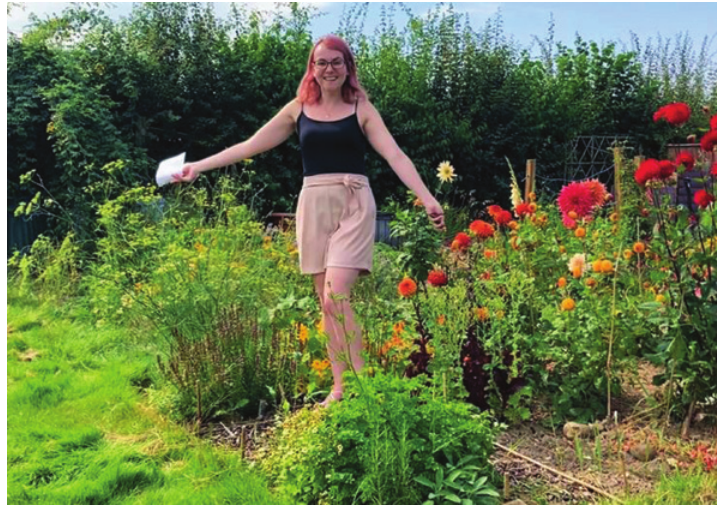
Figure 11 Lorna Webb (Source: photograph by